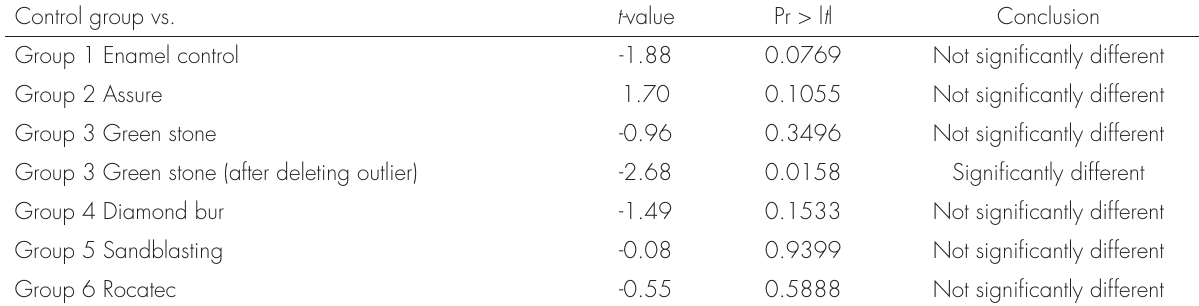
Table II. t- test values determining significant differences between the porcelain control and test groups.